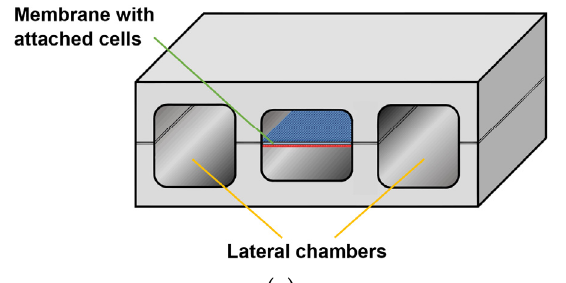
Figure 17. Schematic of the lung-on-a-chip developed by [104,105]: ( a ) in initial relaxed state; ( b ) by applying vacuum to the lateral microchambers, an elastic deformation in the membrane attached with alveolar epithelium and capillary endothelium cells mimics the mechanical distortion of the alveolar–capillary interface produced during the breathing process.